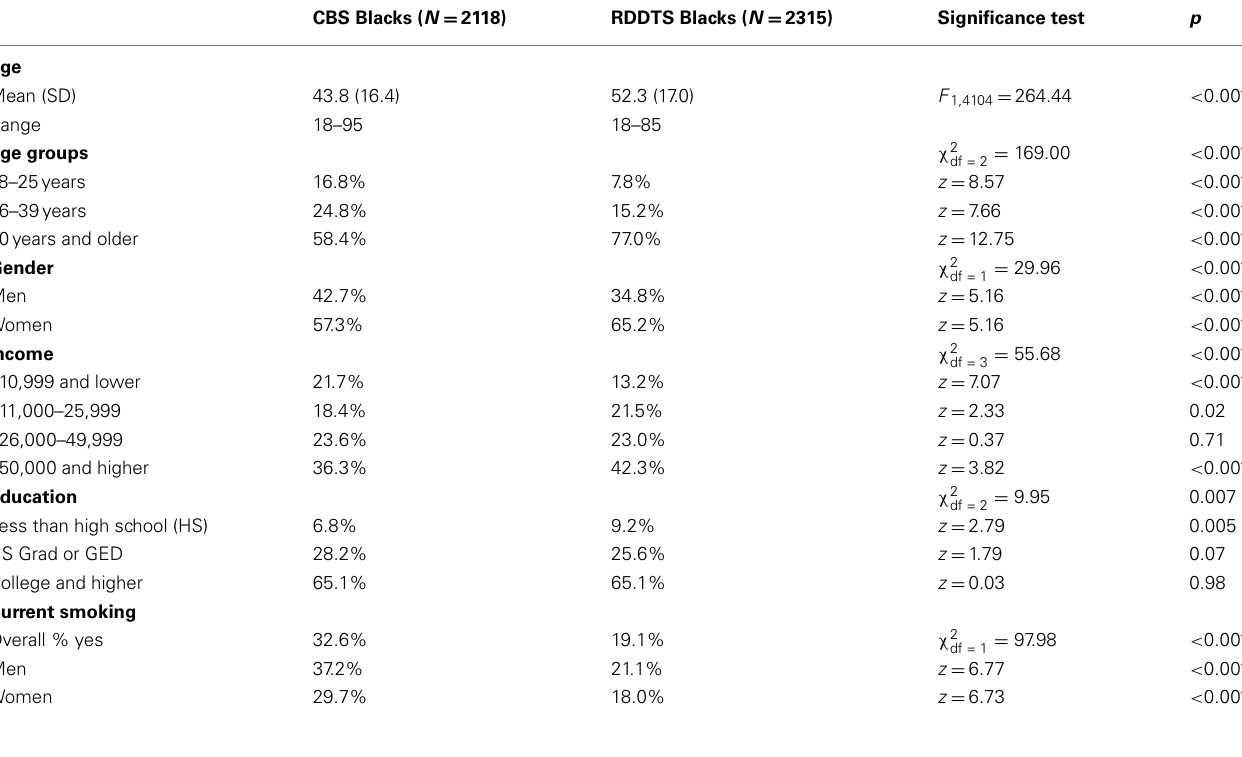
Table 1 | Demographics and smoking among community (CBS) and telephone (RDDTS) Black